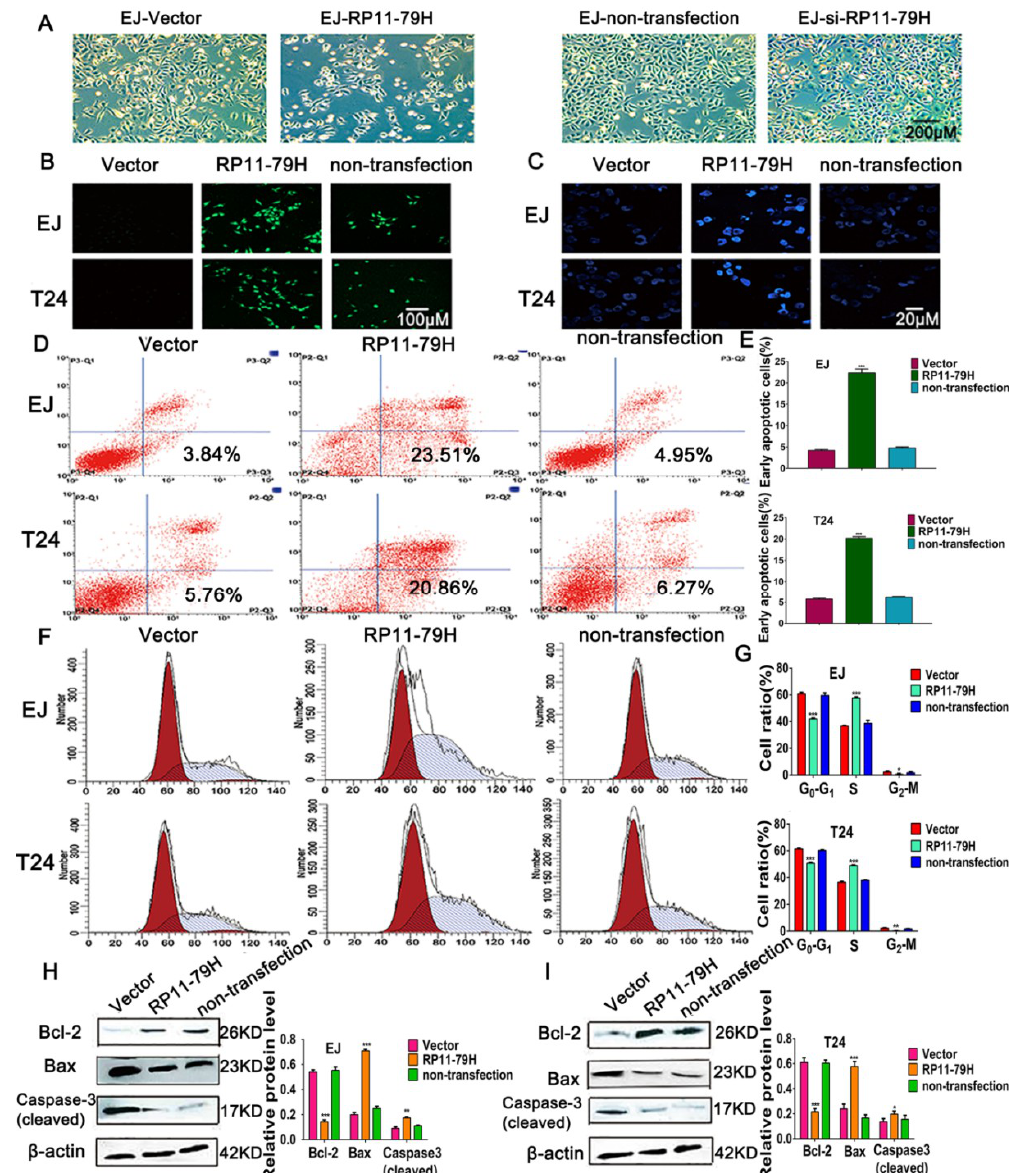
Figure 3. Upregulation of RP11-79H23.3 induces apoptosis and represses BC cell cycle progression. ( A ) The living cell photomicrographs were shot using a phase contrast microscope (scale bar, 200 µm). ( B ) Representative photographs of TUNEL staining of cells were observed (scale bar, 100 µm). ( C ) The typical images of Hoechst 33342 staining were taken (scale bar, 20 µm). ( D , E ) Apoptosis was determined by flow cytometric analysis of Annexin-V/PI staining and the apoptotic index was calculated. ( F , G ) Flow cytometry images by propidium iodide staining and cell cycle distribution were indicated. ( H , I ) The expressions of apoptosis-regulatory proteins were determined by Western blot. Each experiment was independently repeated at least three times. Data is shown as mean ± SD, * p < 0.05, ** p < 0.01, *** p < 0.001.